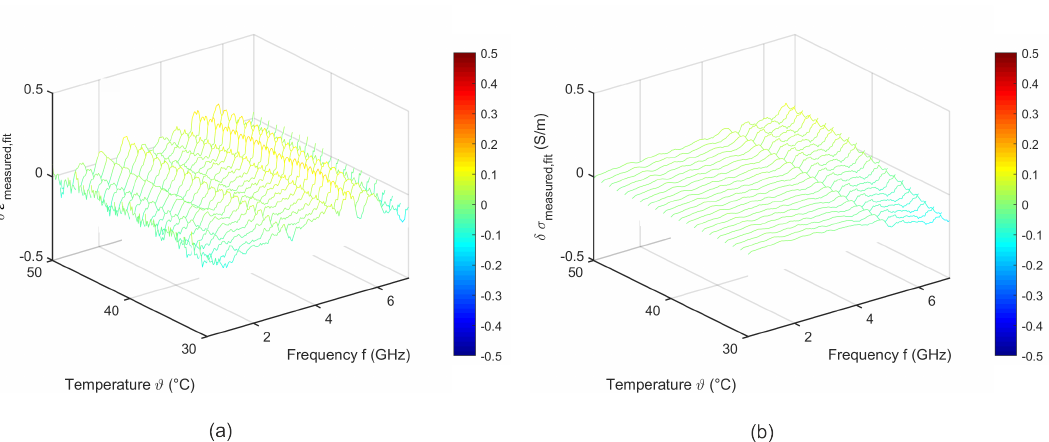
Figure 9. Difference between the measured data and the temperature dependent two pole Cole-Cole model of ( a ) relative permittivity and ( b ) effective conductivity of porcine liver.